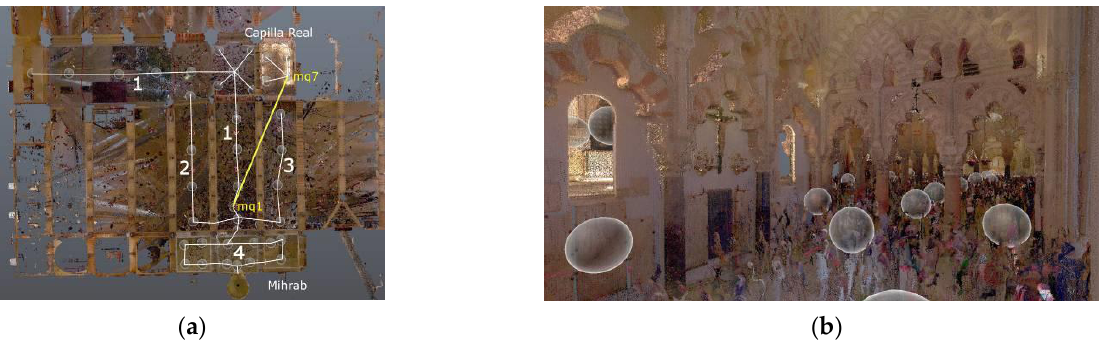
Figure 15. Scan trajectories. ( a ) General plan; ( b ) interior view (the spheres mark the scanner positions). Source: Own images.